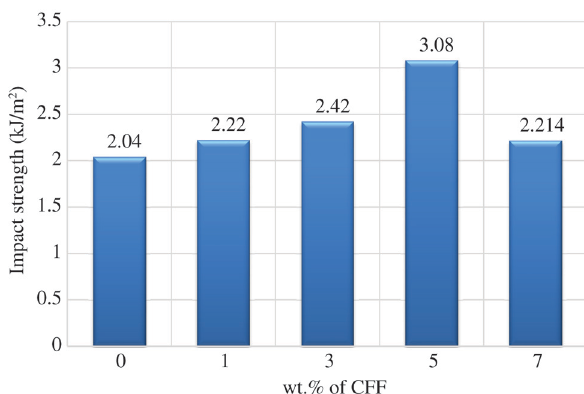
Figure 15: Impact strength for various compositions of CFF composite.